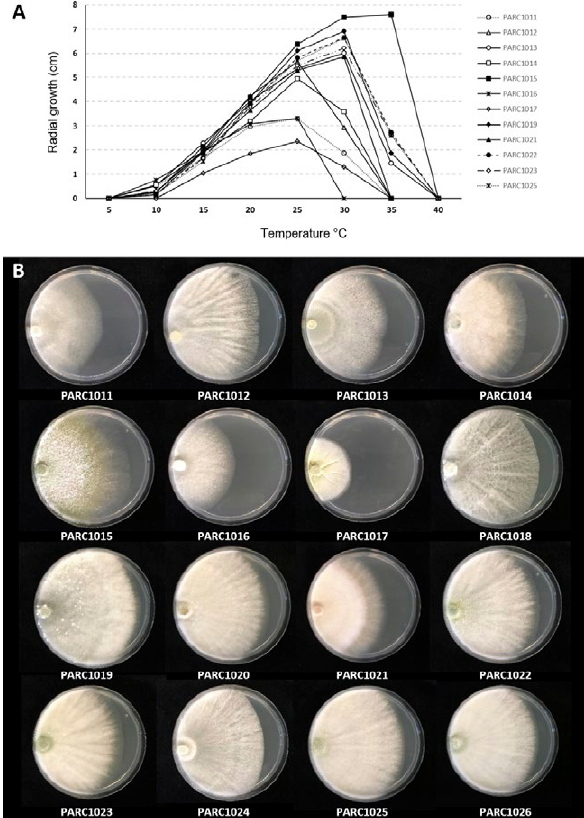
Figure 4. Phenotypical features of Trichoderma isolates from south- ern Italy. A. Mean radial mycelium growth at different temperatures after 72 h. B. Colony growth and colour after 72 h on potato dex- trose agar for the different Trichoderma isolates from southern Italy used in this